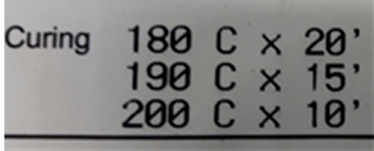
Figure 4. The requirements of the paint manufacturer.